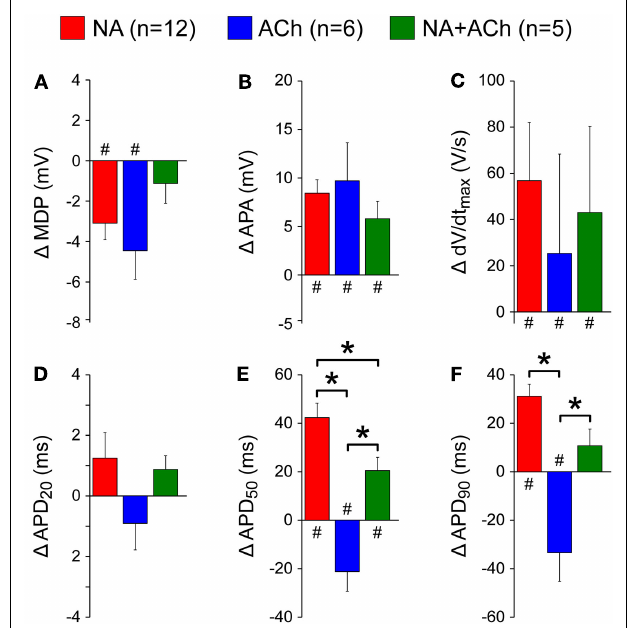
FIGURE 5 | Change in action potential parameters of isolated rabbit left atrial myocytes in response to 1 μ M noradrenalin (“NA,” red bars), 1 μ M acetylcholine (“ACh,” blue bars), or a combination of both noradrenalin and acetylcholine (“NA + ACh,” green bars). Asterisks indicate significant differences between effects of noradrenalin, acetylcholine, or a combination of both. Hashes indicate significant differences from control. (A) Change in maximum diastolic potential (MDP). (B) Change in action potential amplitude (APA). (C) Change in maximum upstroke velocity ( dV / dt max ). (D) Change in action potential duration at 20% repolarization (APD 20 ). (E) Change in action potential duration at 50% repolarization (APD 50 ). (F) Change in action potential duration at